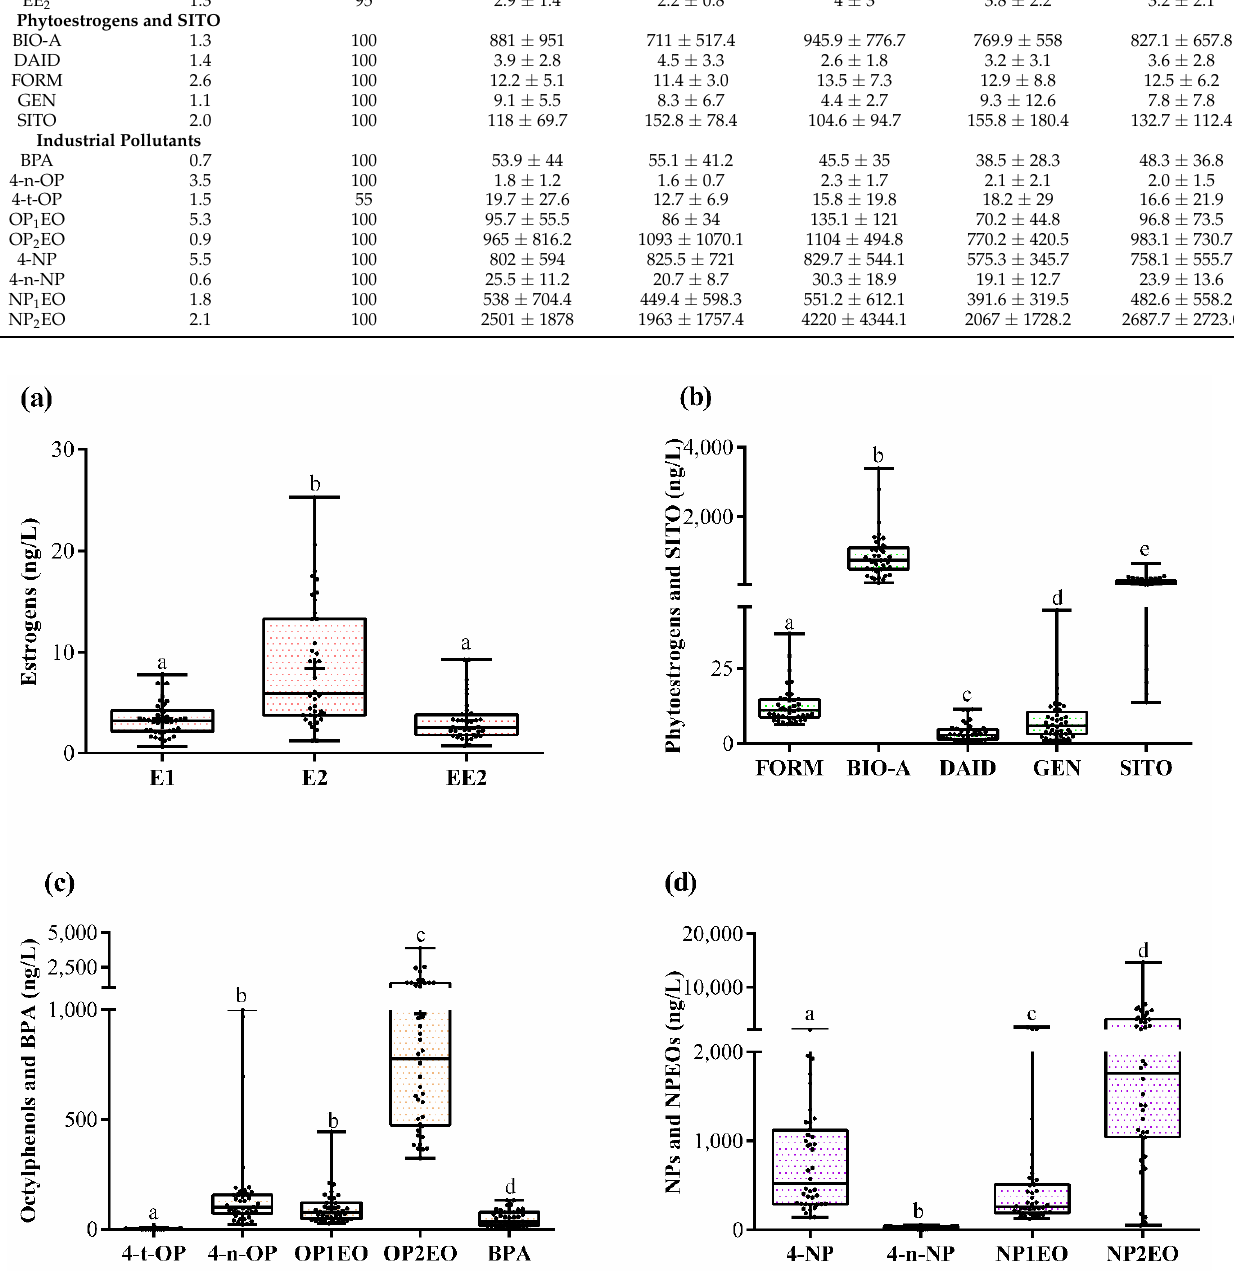
Figure 2. Global levels (ng/L) of: ( a ) oestrogens; ( b ) phytoestrogens and SITO; ( c ) OPs, OPEOs and BPA; ( d ) NPs and NPEOs. Data are expressed in boxplots with the minimum, median, maximum, average (+), and interquartile ranges Q1–Q3. Dots represent average individual values measured in ten areas (n = 40). Different low case letters indicate significant differences amongst sampling sites ( p < 0.05).